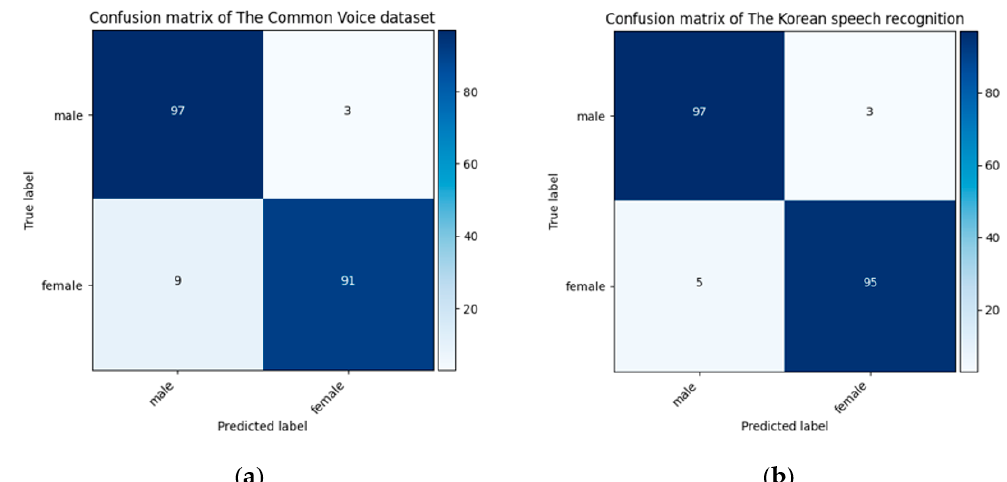
Figure 6. Obtained confusion matrices of the proposed model for the Common Voice ( a ) and Korean speech recognition ( b ) dataset for gender classification with average recognition rates of 96% for both datasets.